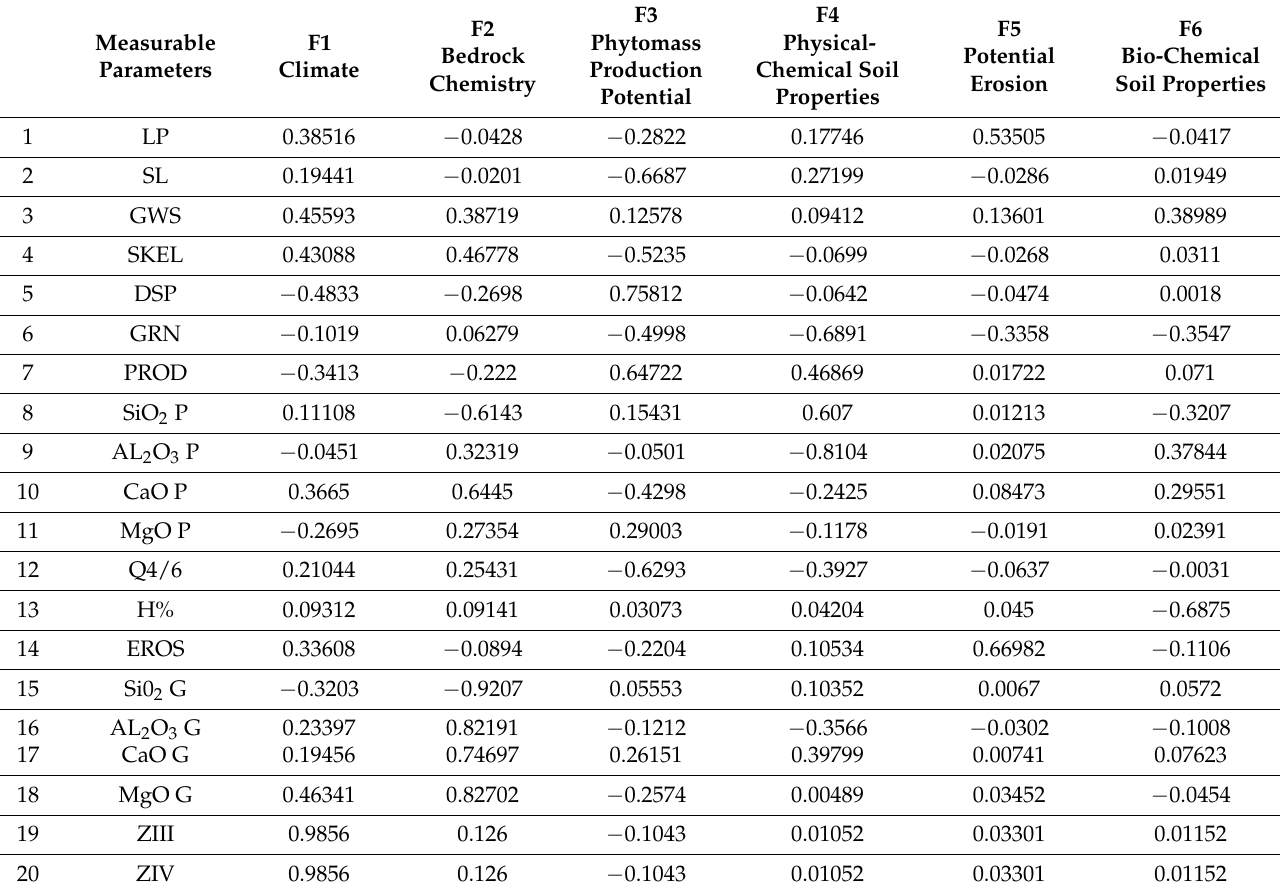
Table 3. Factor loads matrix for six significant